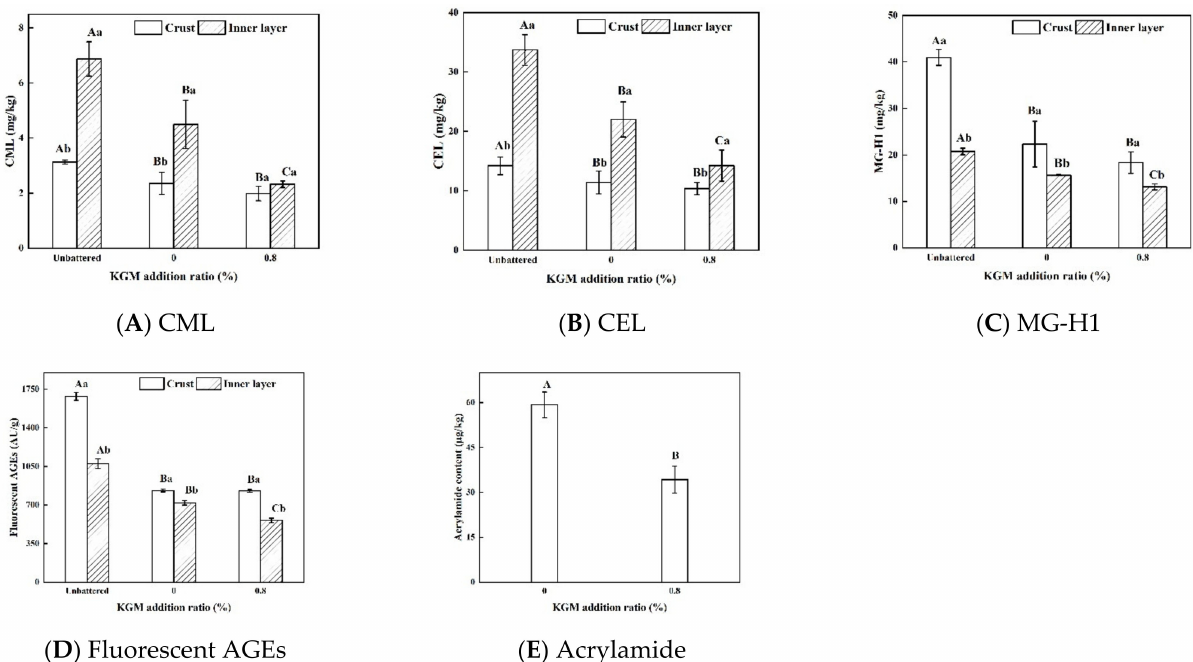
Figure 5. Nonfluorescent, fluorescent AGEs and acrylamide contents of fried fish nuggets with KGM. Note: Different capital letters indicate that there are significant differences between different conditions ( p < 0.05). Different lowercase letters indicate that there are significant differences between the crust and the inner layer in the same condition ( p <